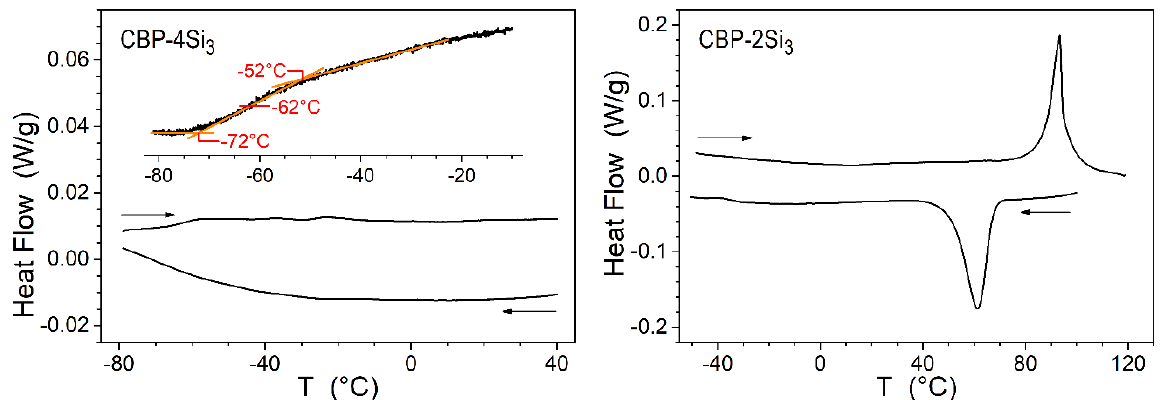
Figure 2. Photographs of CBP-4Si 3 under ambient visible light ( right ) and ultraviolet light ( left ).